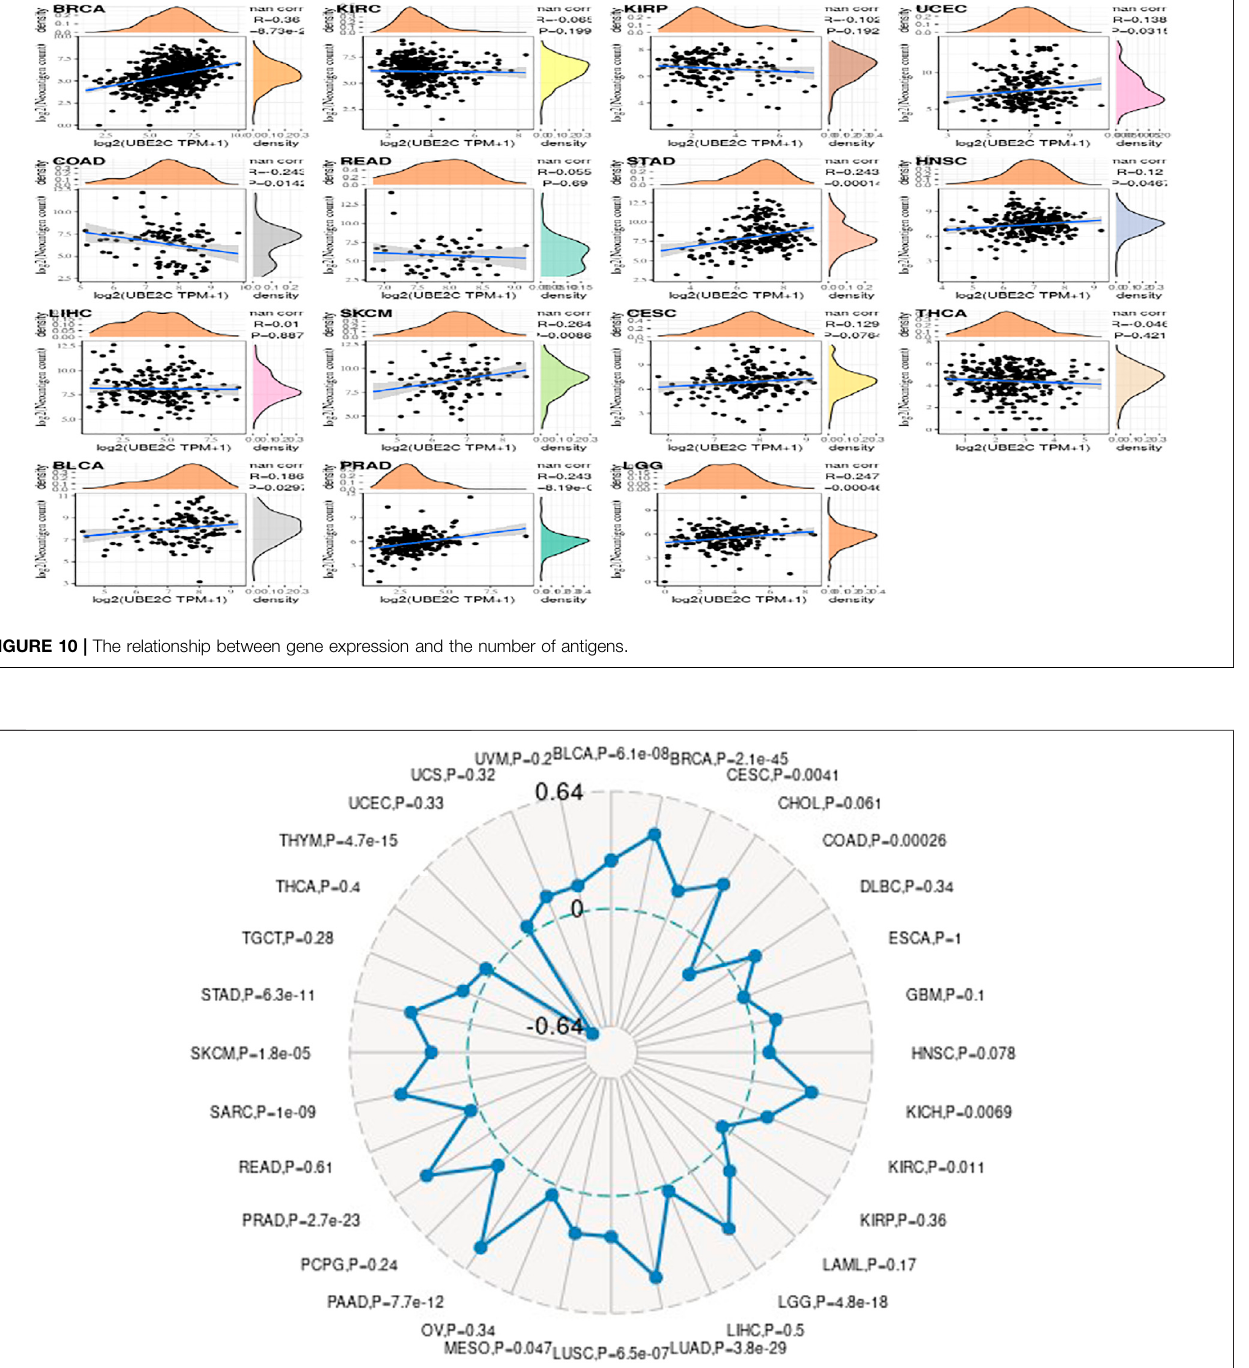
Frontiers in Genetics |